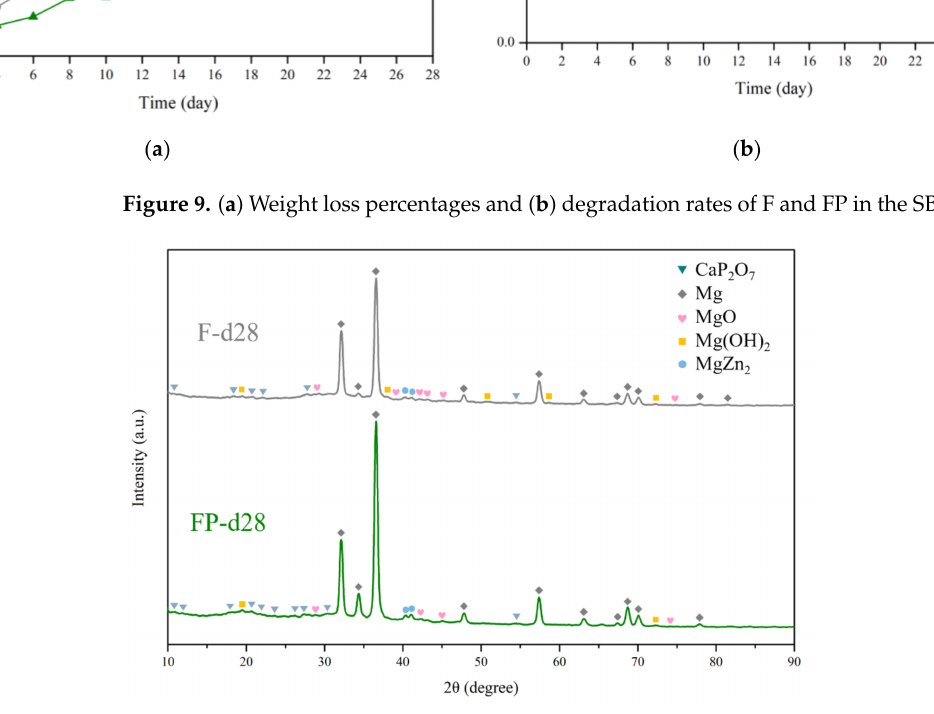
Figure 10. XRD patterns of F and FP after immersed in SBF for 28 days.